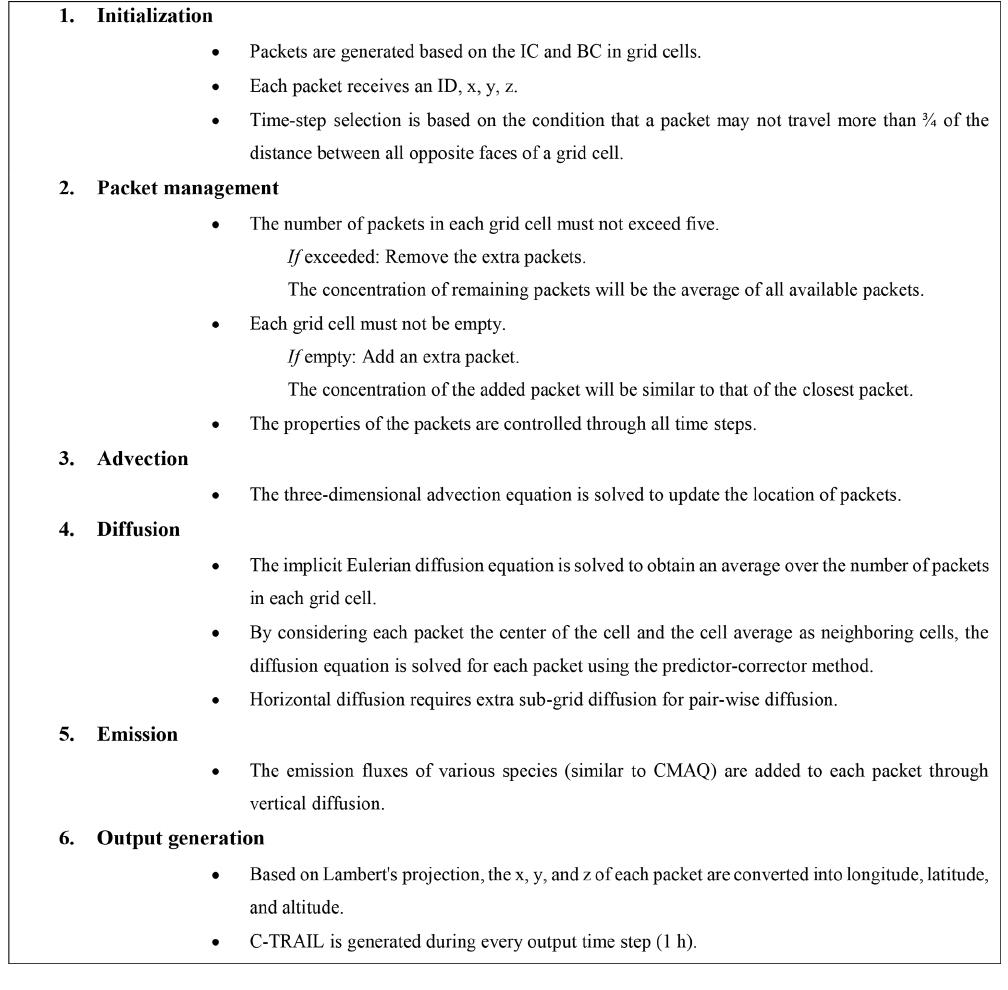
Figure 2. Algorithm of the C-TRAIL model. Table 1. Comparison of the statistical parameters of CMAQ CO concentrations to aircraft measurements (COR: correlation; IOA: index of agreement; RMSE: root mean square error; MAE: mean absolute